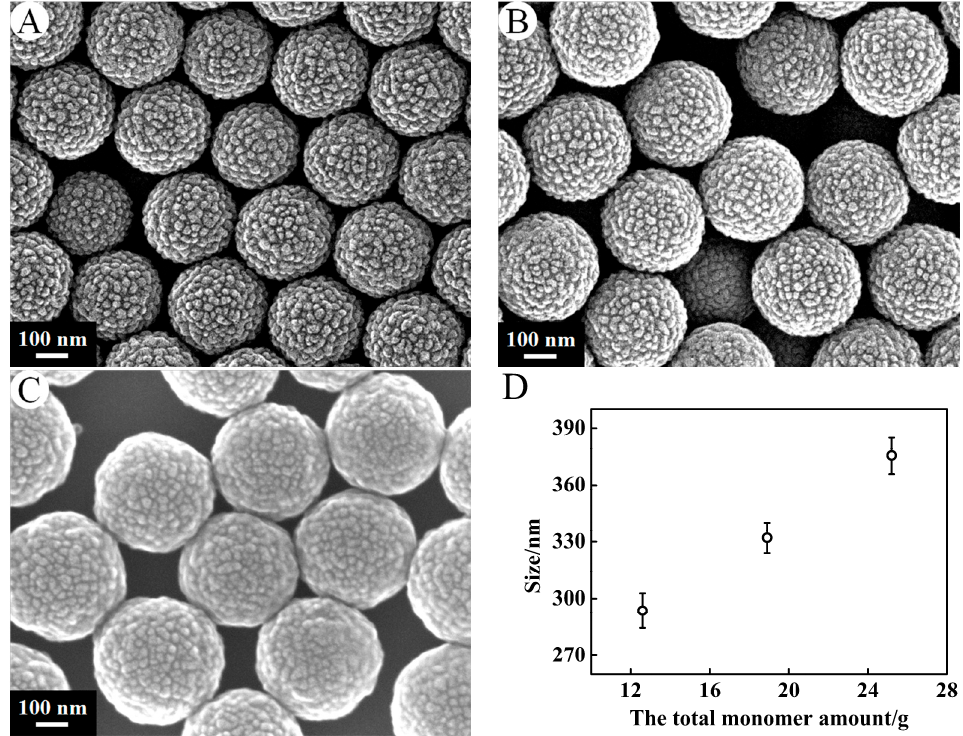
Figure 5. SEM micrographs of PSA nanospheres under preparation conditions of the total monomer amount ( A ) 12.6 g, ( B ) 18.9 g, ( C ) 25.2 g. Other conditions: KPS, 0.24 g; stirrer speed, 300 r·min − 1 . Effects of the total monomer amount on the size of the PSA nanospheres ( D ).